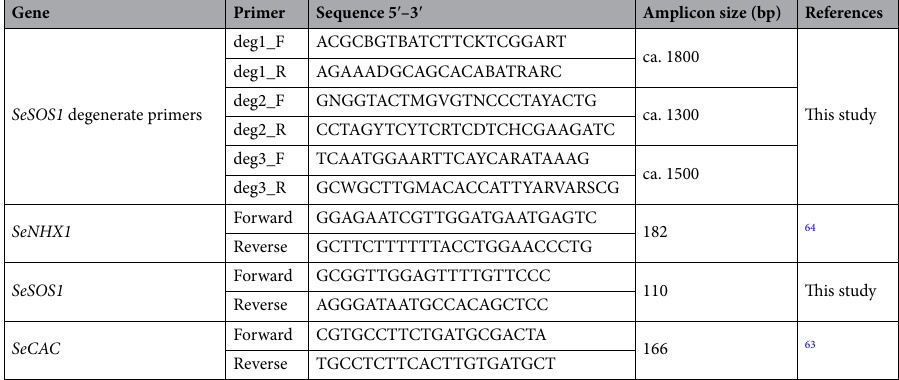
Table 4. Sequences of the primers used for cloning of SeSOS1 and quantitative real-time